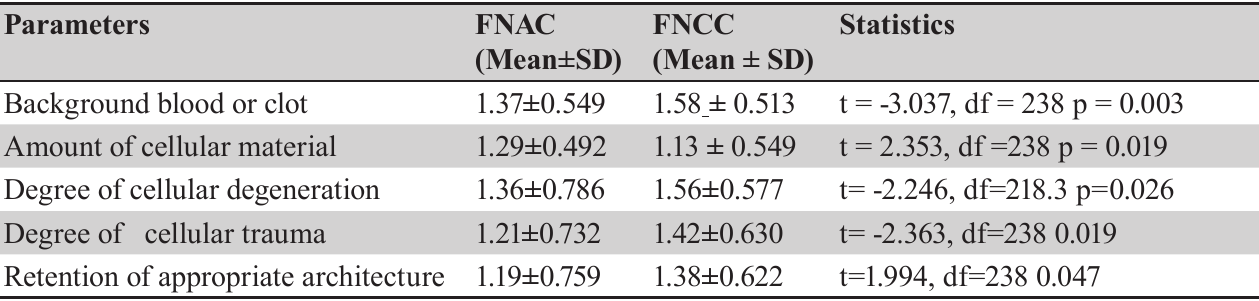
Table 4. Comparison of FNAC and FNCC for various parameters.